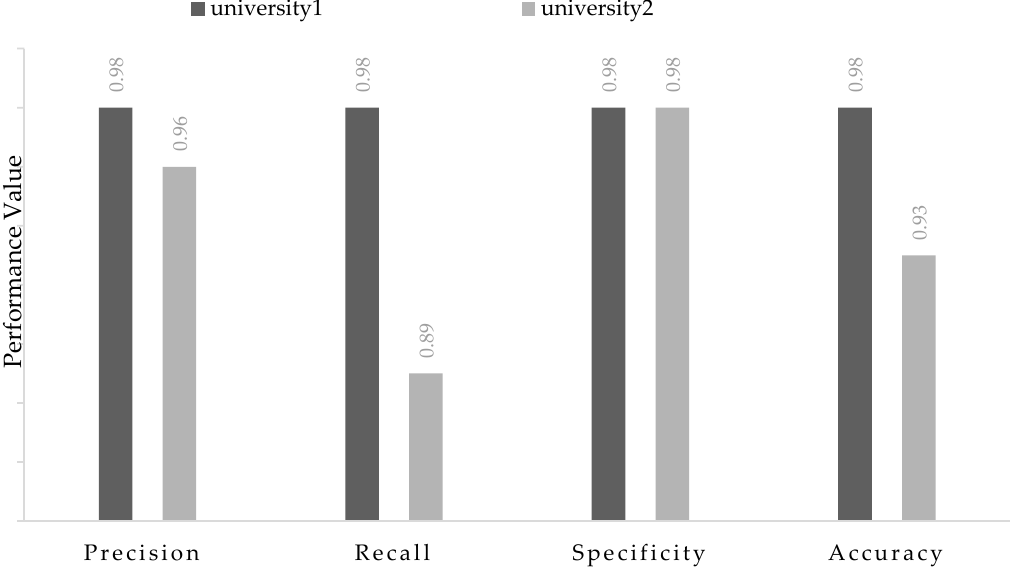
Figure 7. Graphical representations of precision, recall, specificity, and accuracy of ID2SBVR-extracted fact type.